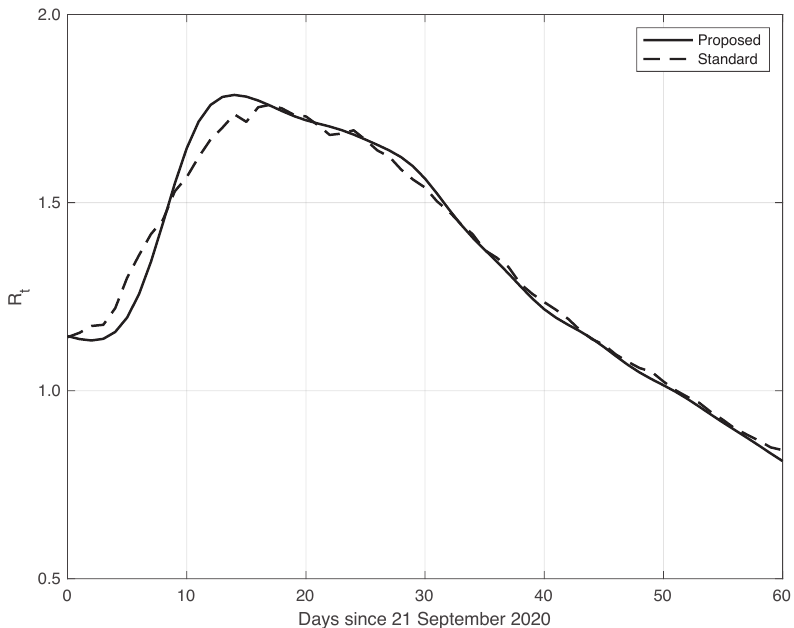
Figure 8. Sequence of the reproduction number R t for real SARS-CoV-2 Italian data from 21 September to 20 November 2020, illustrated in Figure 1. The continuous line corresponds to the proposed method, while the dashed line corresponds to the standard approach.